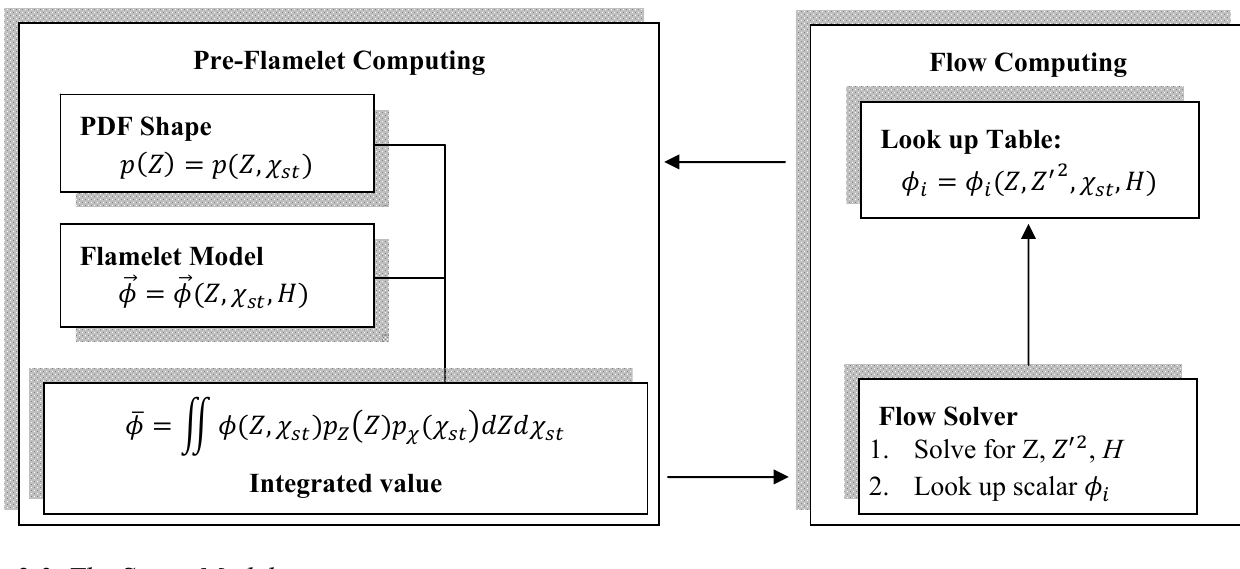
Figure 3. Flamelet model